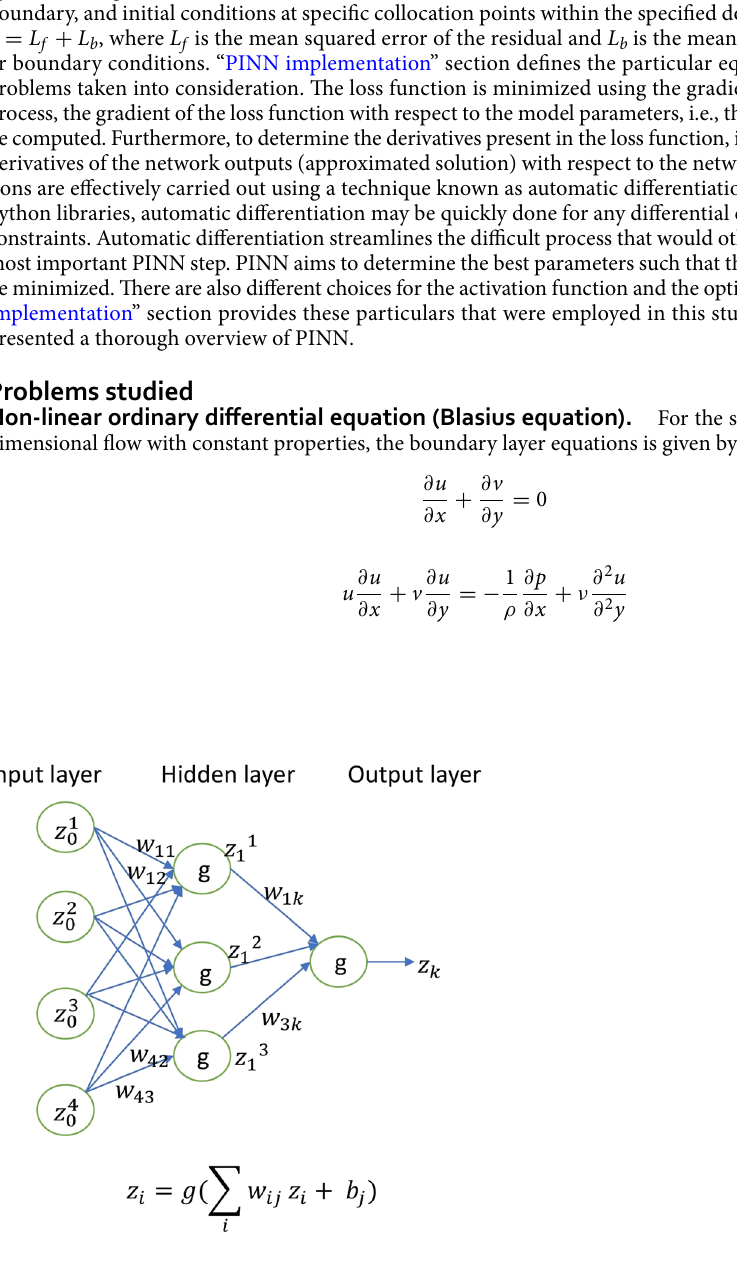
Figure 1. Schematic representation of neural